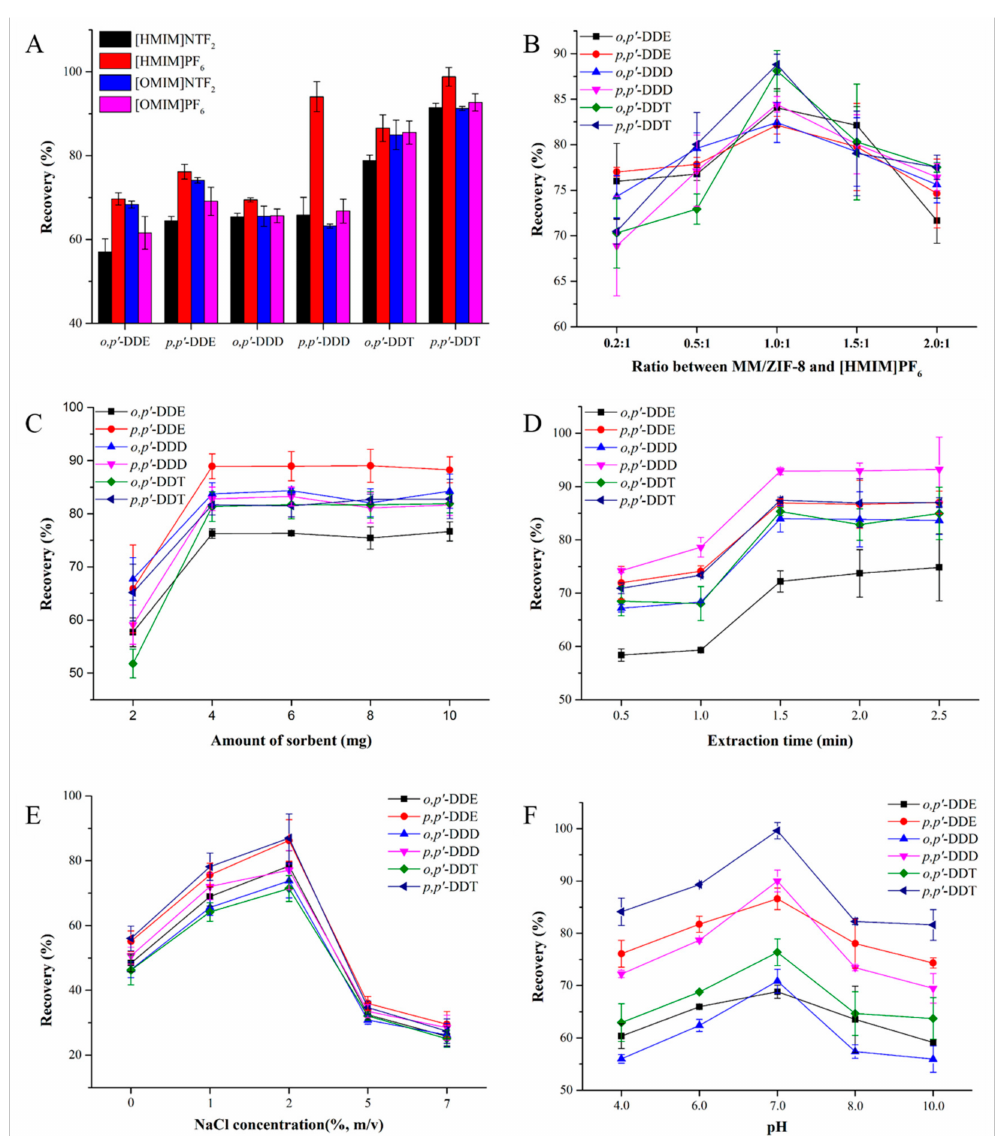
Figure 2. E ff ects of di ff erent parameters on the extraction e ffi ciency of dichlorodiphenyltrichloroethanes (DDTs): ( A )typeofIL,( B )massratioofMM / ZIF-8and[HMIM]PF 6 , ( C )amountofsorbent, ( D )extraction time, ( E ) salt addition, and ( F ) sample